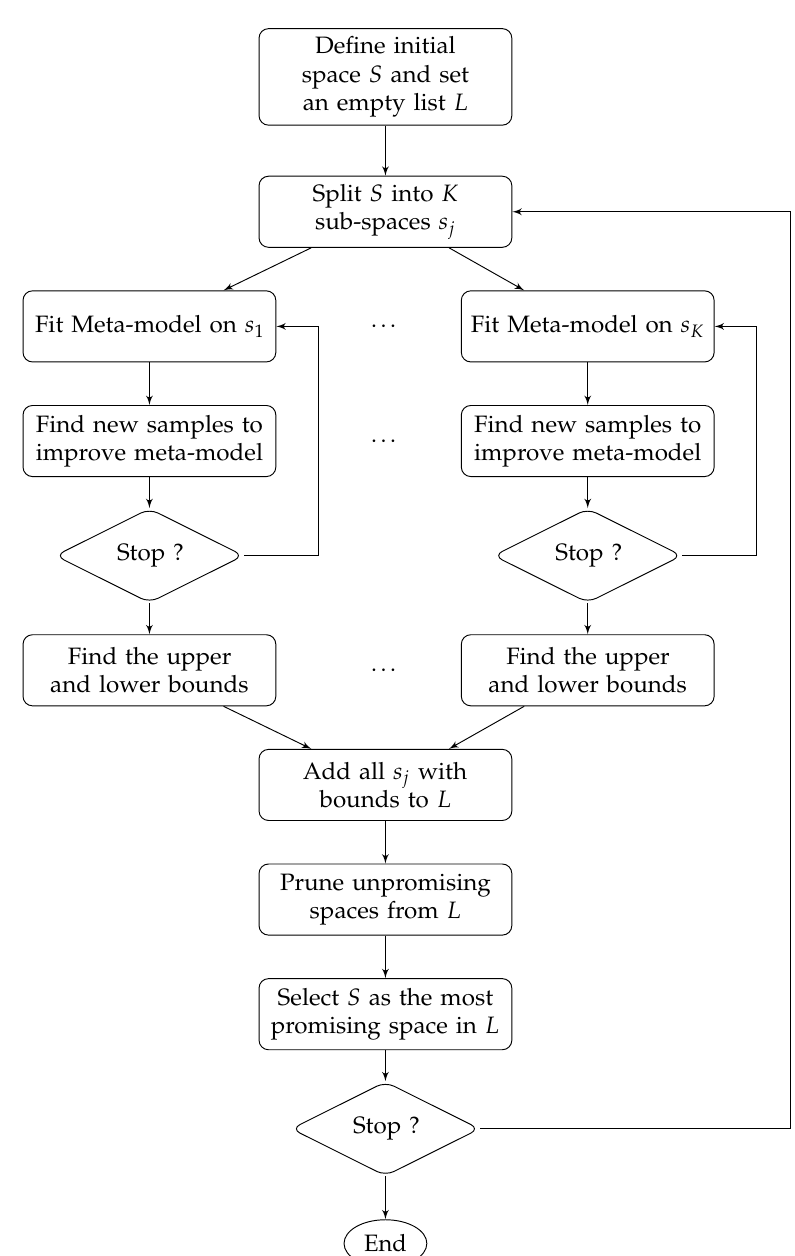
Figure 1. Flowchart of B2M2.